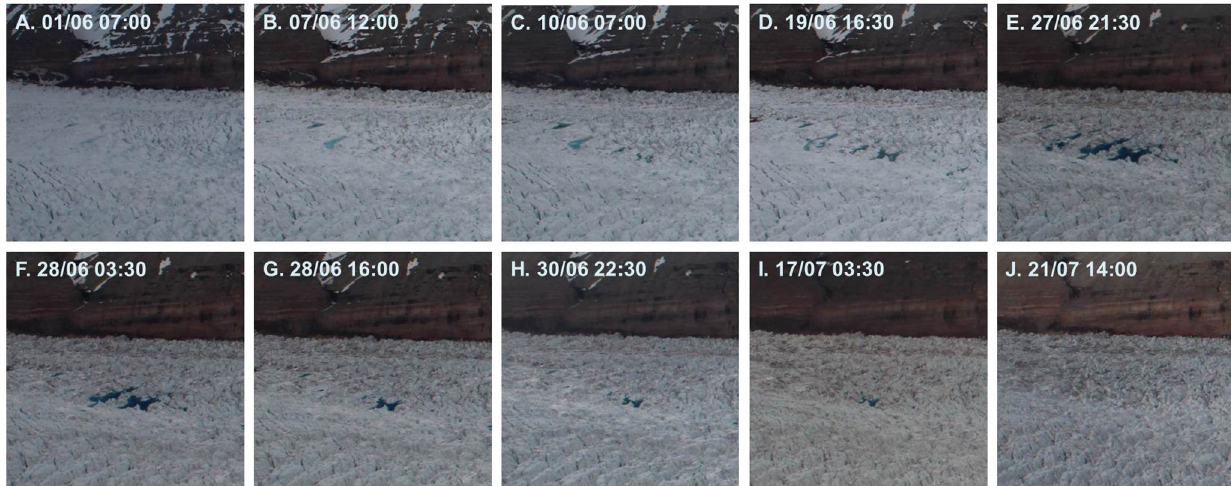
Figure 3. Selected time-lapse imagery showing the filling and drainage of the individual lakes in Cluster 1. The glacier flows from right to left. (a) Frozen water presides in crevasses. (b) Frozen water thaws and lakes gradually fill. (c) Up-glacier crevasses begin to fill with water. (d) All lakes continue to fill simultaneously. (e) Lakes at maximum surface area. (f) Down-glacier lakes drain and no remaining water is visible from the given camera angle. (g) Up-glacier lakes partially drain and some remaining water is visible. (h, i) Up-glacier lakes continue to drain gradually. (j) No remaining water is visible in any of the lakes by this